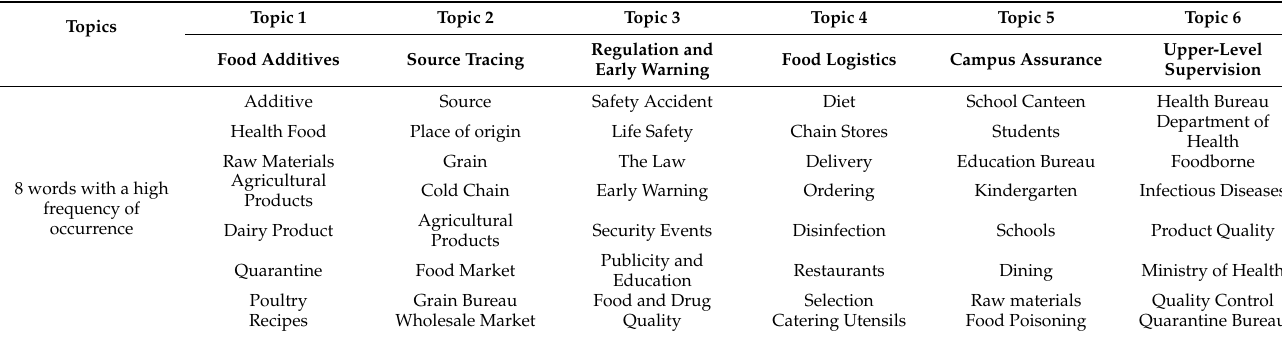
Table 3. Hot words with 6 Topics for